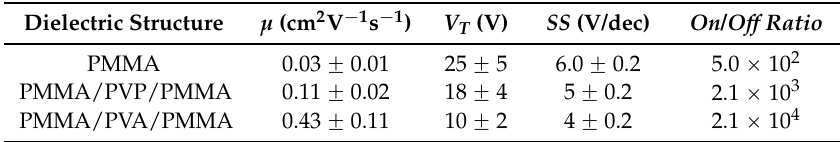
Figure 6. Transfer ( V DS = 40 V) and output ( V G = 0 to 40 V, with a 10 V step) characteristics of PTCDI-C8-based OFETs with different dielectric structures. ( a , d ) PMMA; ( b , e ) PMMA/PVP/PMMA; ( c , f ) PMMA/PVA/PMMA. Table 2. Characteristics of PTCDI-C8-based OFETs with different dielectric structures.